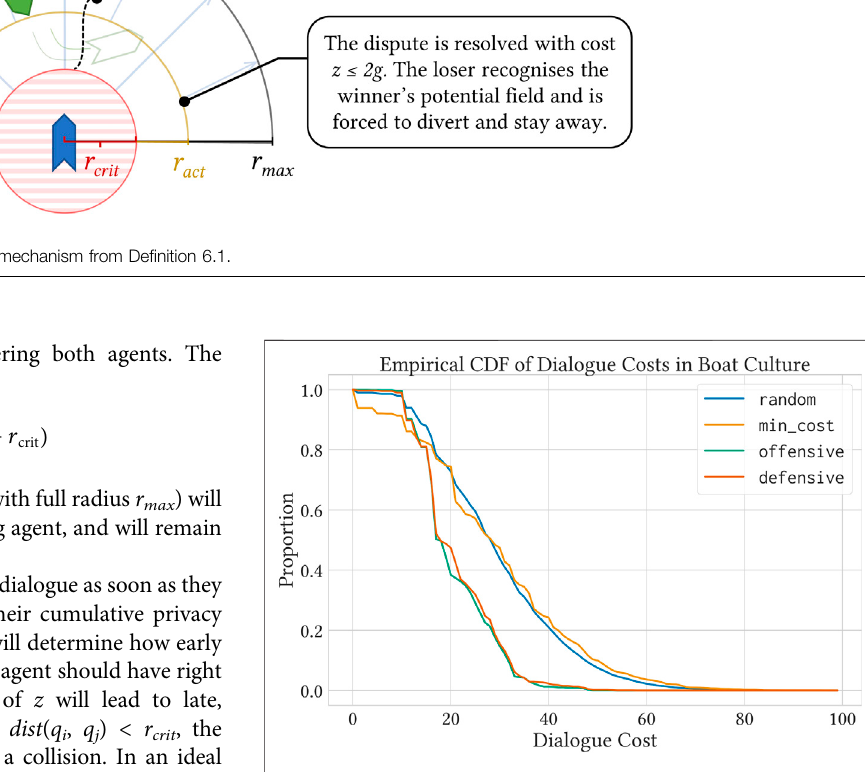
FIGURE 6 | Privacy costs for unrestricted dialogues in our instantiated Boat Culture (as shown in Table 1 ). Note that some behaviors are different from Figure 3 . Contrary to the randomised case, where over 2000 different cultures are tested, this plot represents dialogues under a single